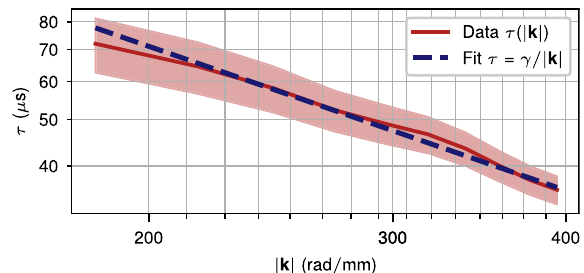
Fig. 5 Dependence of the decoherence rate τ ( ∣ k ∣ ) on the spin-wave wavevector length ∣ k ∣ . Data was obtained by selecting wavevectors with the same decoherence rate for both polarizations c H ( t ) = c V ( t ) (i.e., y s (cid:5) y max = 2) from the BSM visibility maps V ð x s ; y s ; t Þ . Data was binned by ffiffiffiffiffiffiffiffiffiffiffiffiffiffiffi p j k j ¼ x 2 þ y 2 and the decoherence model, given by Eq. (28), was fi tted s s simultaneously to all bins (the same W ; V 0 , different τ ). Resulting τ ( ∣ k ∣ ) corresponds to the solid line (Data) and the shaded area depicting a standard deviation. Dashed line (Fit) represents the fi t of τ ( ∣ k ∣ ) = γ / ∣ k ∣ with obtained γ = 5.98 × 10 3 μ s rad mm − 1 corresponding to a temperature of 52 μ K. Other fi t parameters are consistent with previous results W = 0.15